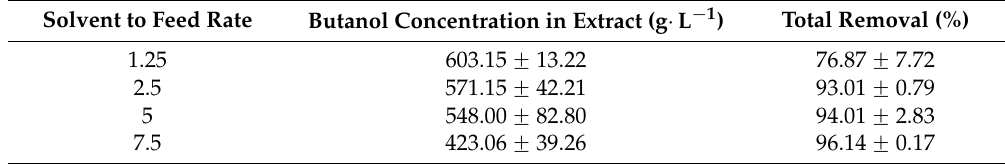
Table 1. Effect of solvent-to-feed ratio on butanol concentration in extract (g·L − 1 ) and total removal (%) after the continuous cycle.